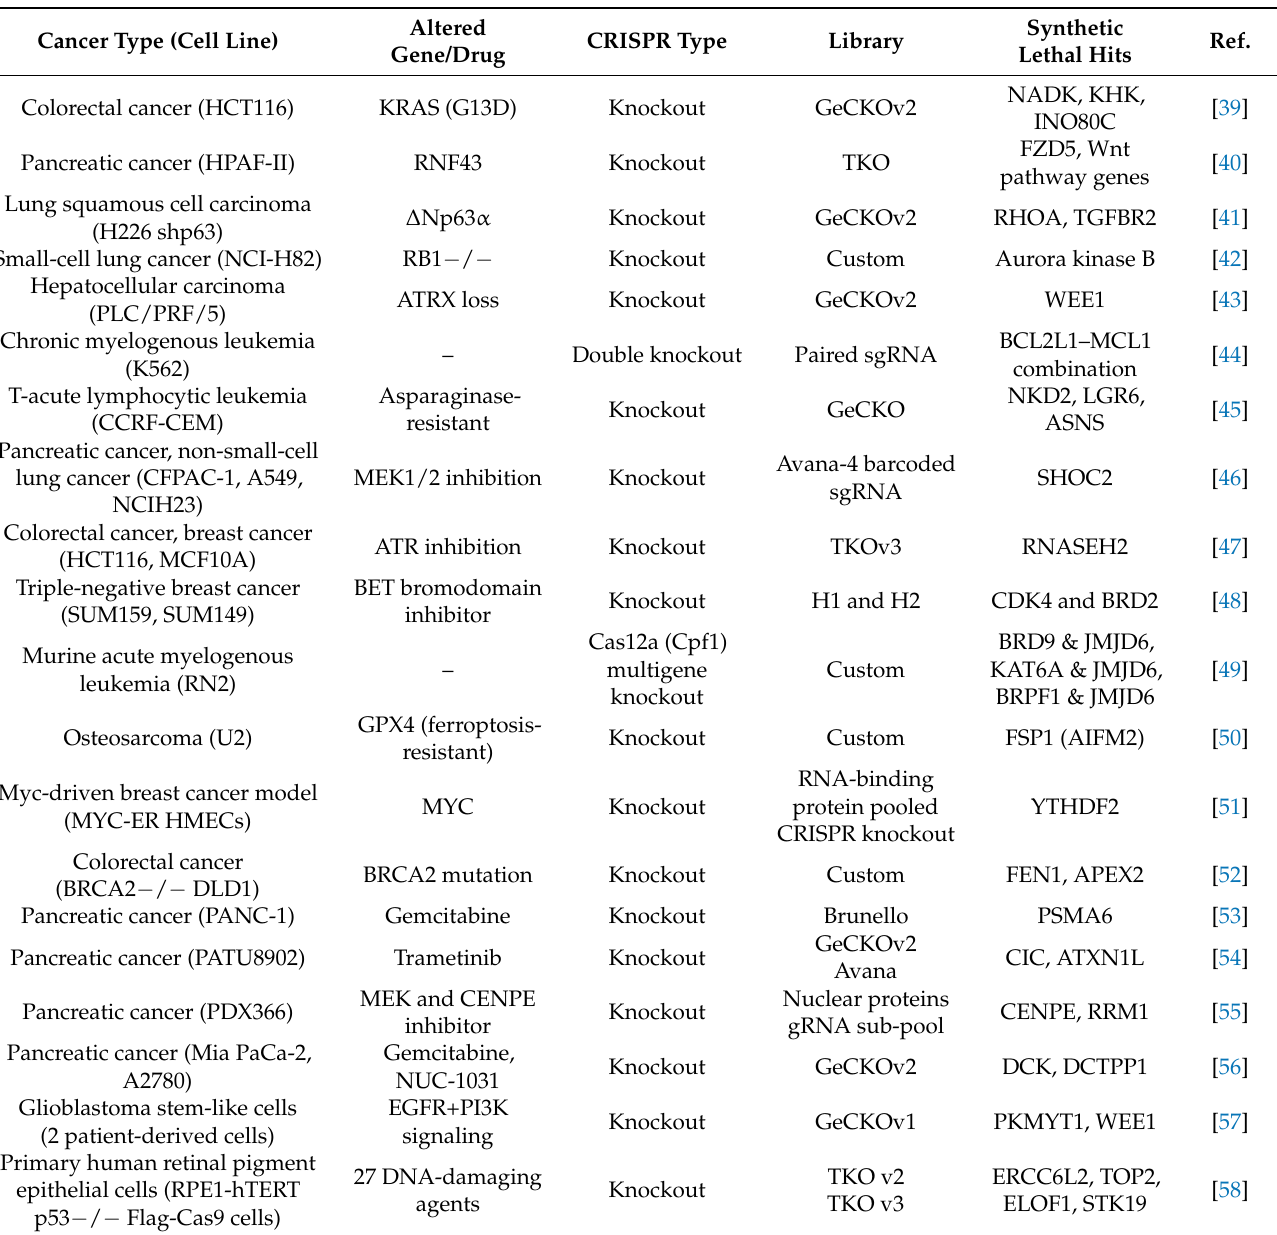
Table 3. CRISPR screening for synthetic lethal